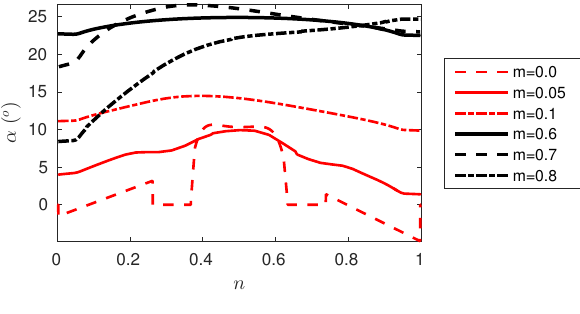
Figure 6. Profiles of the time-averaged flow angle relative the tangent for reference inlet flow angle α IN = 9.5 ◦ for different locations along the meridional indicated in the